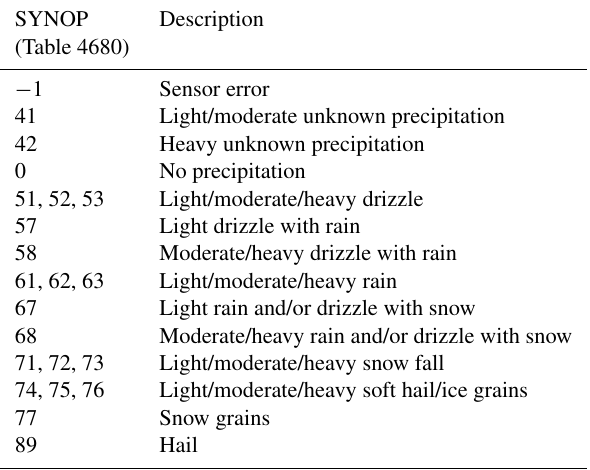
Table 2. World Meteorological Organization (WMO) synoptic present weather codes (Table 4680) output by the Thies laser pre- cipitation monitor